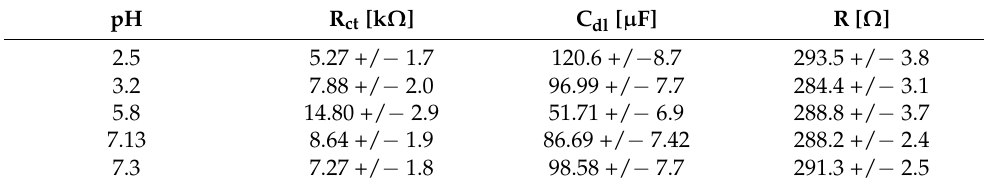
Figure 7. ( a ) EIS curves obtained with the sensor at 4 acidic pH values as example, ( b ) equivalent circuit used to determine electrochemical parameters, ( c ) double layer capacitance, ( d ) solution resistance and ( e ) charge transfer resistance variation of the electrochemical sensor with pH values. Table 2. Values of Rct, Cdl and R obtained by the fitting of EIS curves through equivalent circuit .